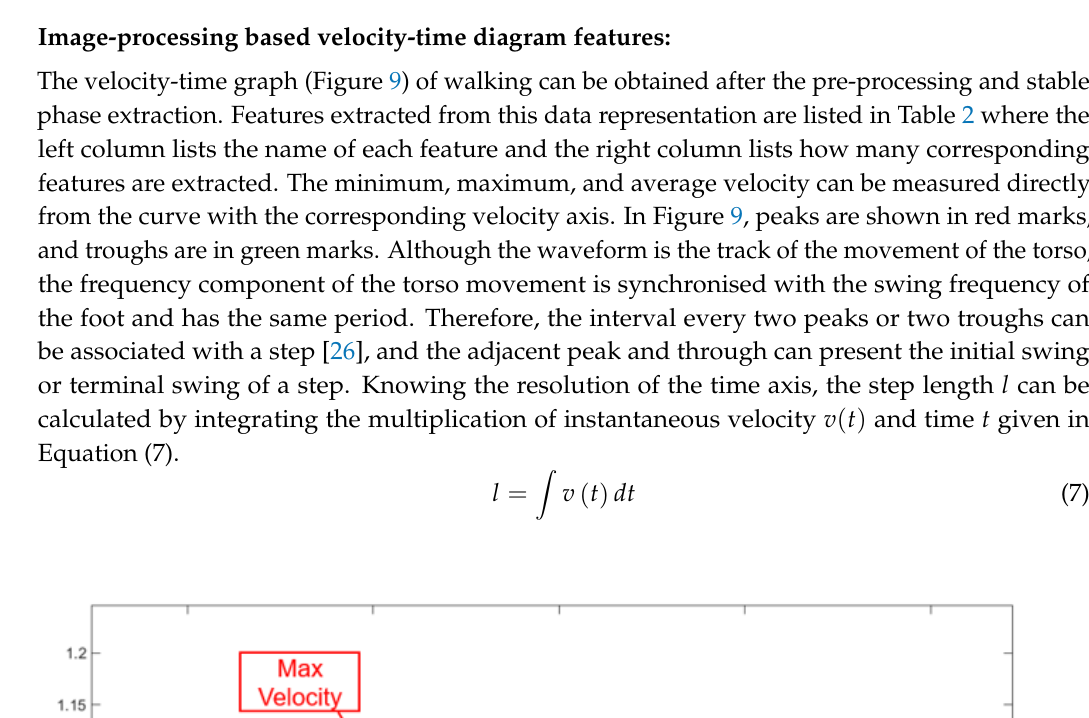
Figure 8. ( a ) Cadence velocity diagram ( b ) Horizontal projection of CVD ( c ) Vertical projection of CVD.